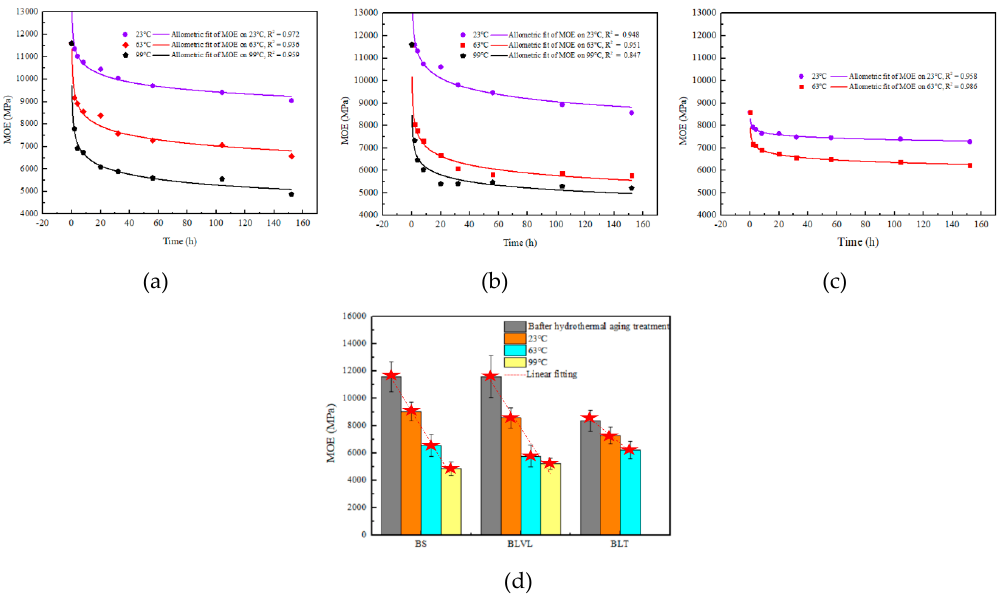
Figure 6. The attenuation law of the elastic modulus (MOE) of three types of bamboo composites. ( a ) BS; ( b ) BLVL; ( c ) BLT; ( d ) The comparison of MOE at different aging temperatures.